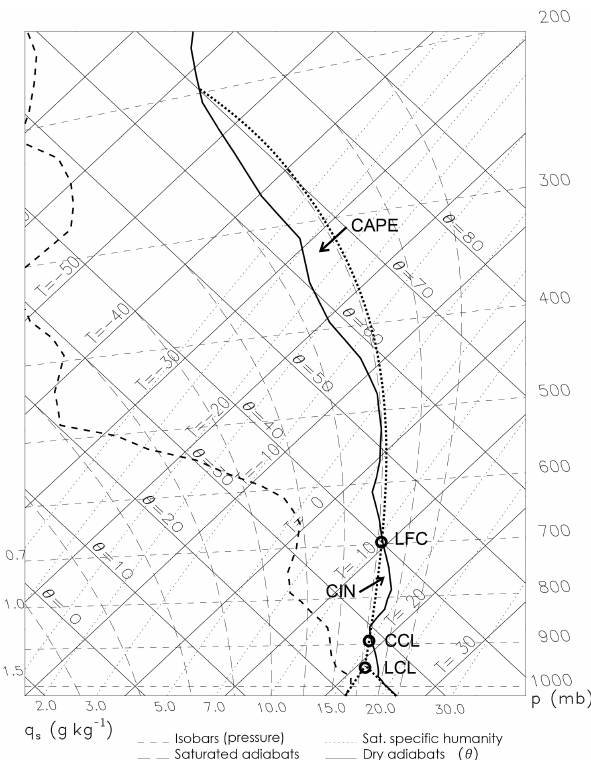
Figure 1. Tephigram representing the vertical profile of the ini- tial dew point temperature (dashed line) and the temperature (solid line). The thick dotted line represents the adiabatic parcel ascent and the circles indicate the specific levels of the parcel such as the lifted condensation level (LCL), the convective condensation level (CCL) and the level of free convection